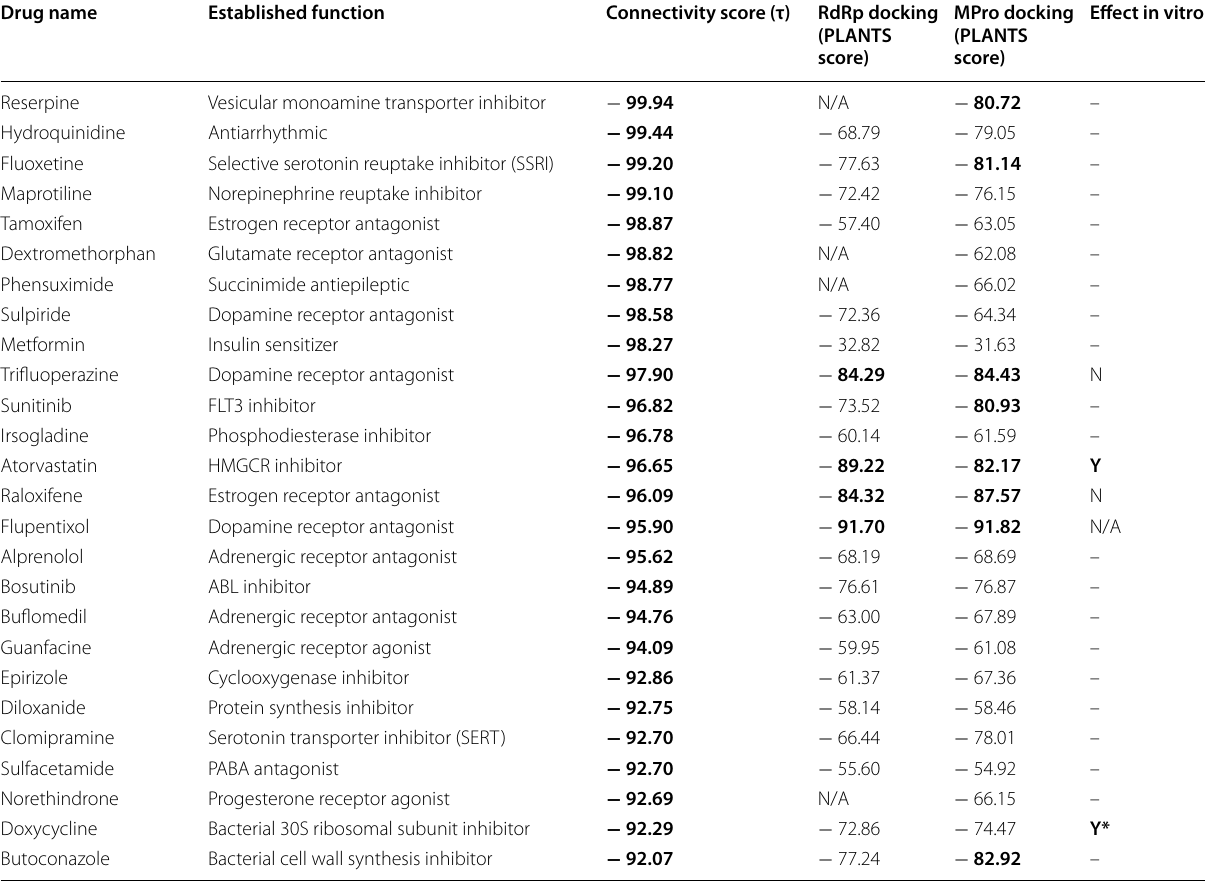
Table 1 Results